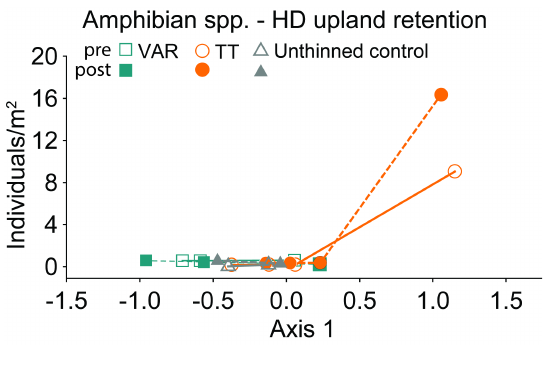
Figure 5. Estimates from generalized mixed model analysis of co-variance testing for the effects of riparian buffer treatments after a second high-density thinning treatment: 1Tree, variable (VAR) and thin-through (TT) and year (pre-treatment = open symbols, solid lines, post-treatment = solid symbols, dashed lines) while controlling for habitat (NMS Axis 1) and sampling method (hand sampling vs. electrofishing). Because significant effects of sampling method (hand sampling vs. electrofishing) were not observed, the methods were plotted